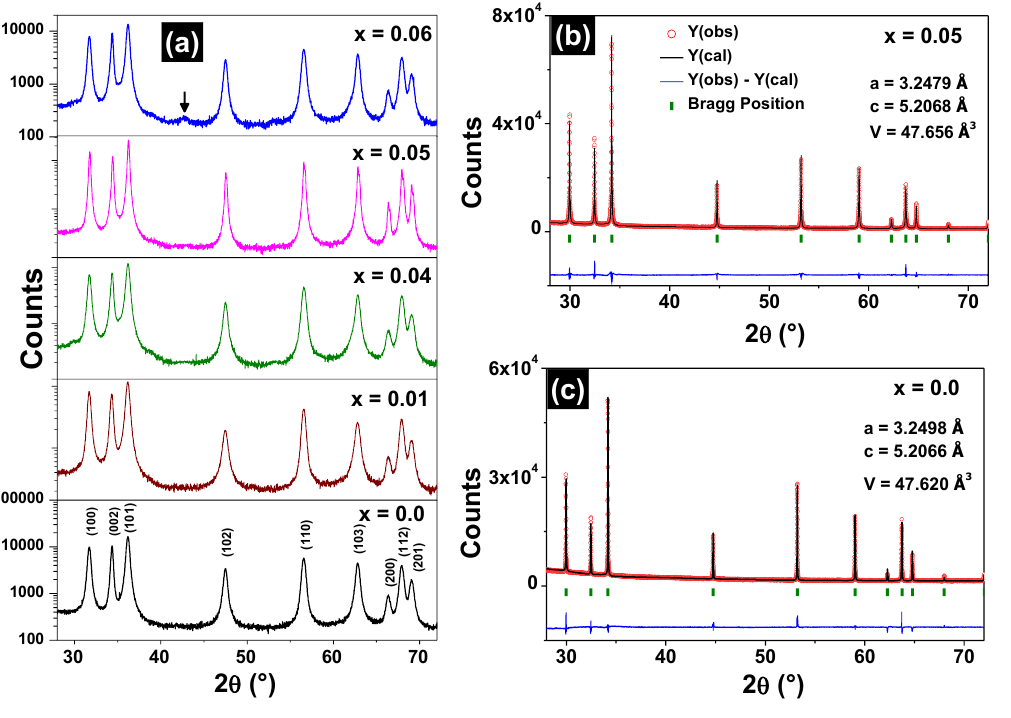
Figure 1. XRD patterns (ordinate in logarithmic scale) of the Zn 1−x Fe x O samples ( a ). The arrow in the x = 0.06 XRD pattern indicates the (400) peak of the ZnFe 2 O 4 phase. Refined diffractograms for the Zn 0.95 Fe 0.05 O ( b ) and ZnO ( c ) samples.